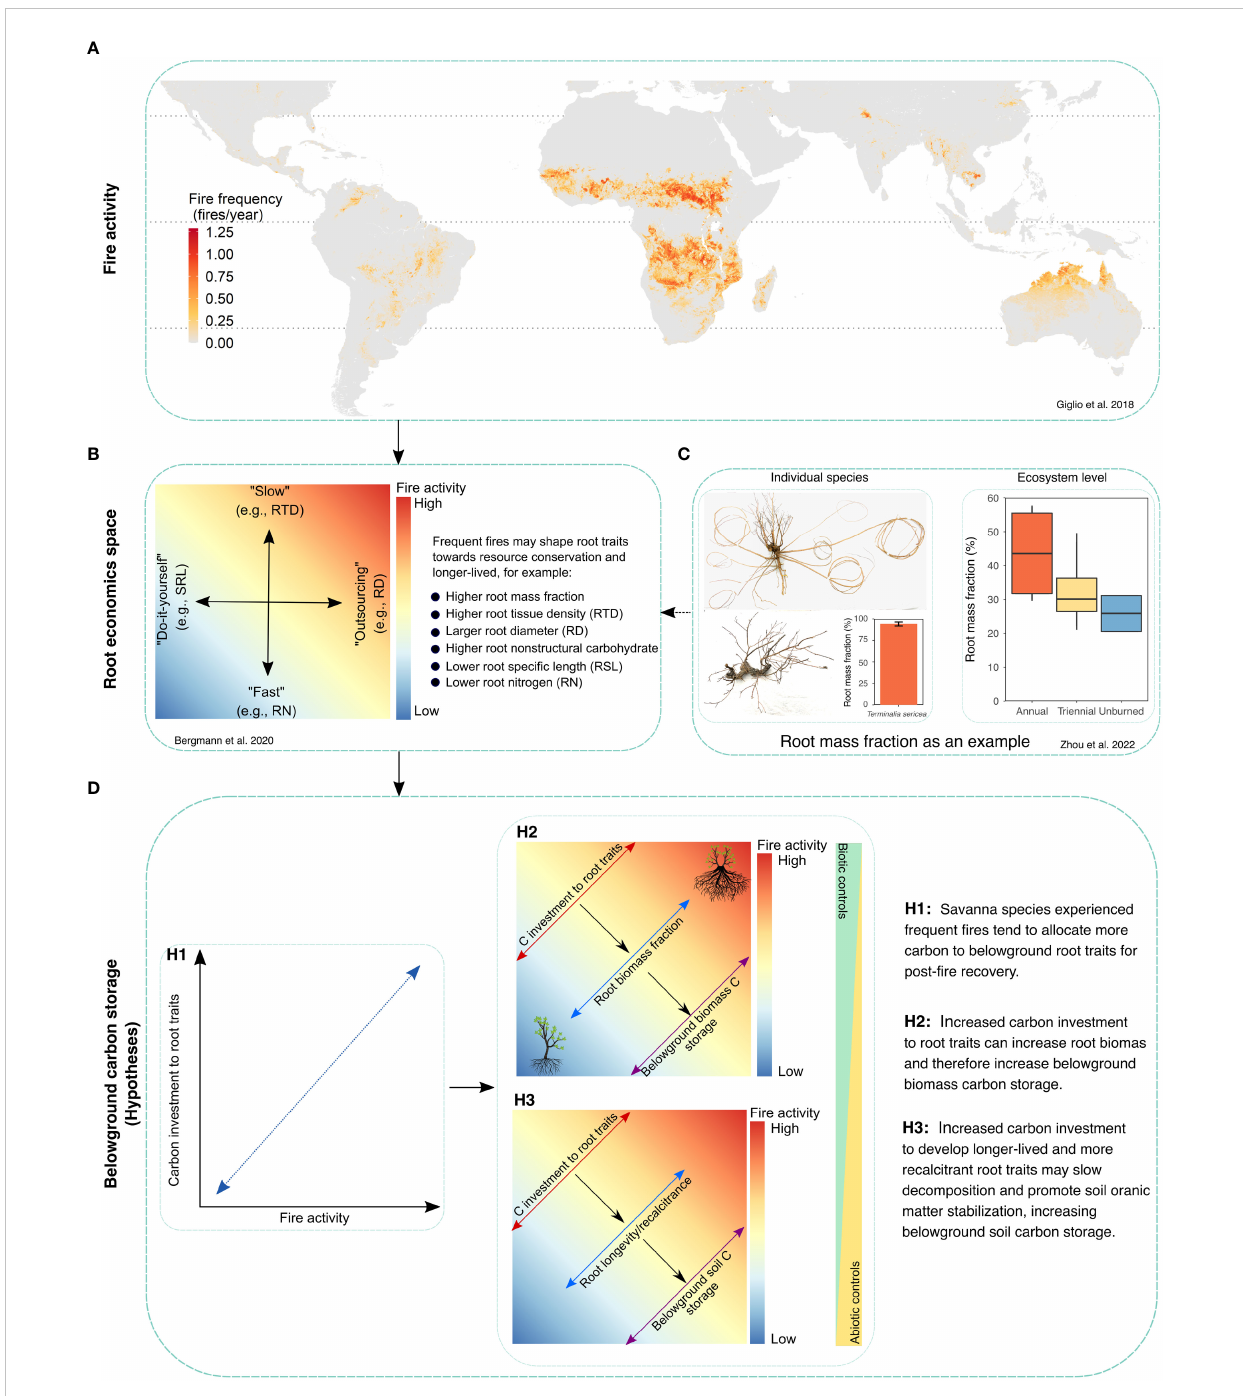
FIGURE 1 Linking root functional trait to understand belowground carbon dynamics in fi re-prone savannas. Panel (A) shows fi re frequency ( fi res/year) across tropical and subtropical savannas. Dataset were from the Moderate Resolution Imaging Spectroradiometer (MODIS) burned area product (Giglio et al., 2018). Panel (B) shows potential response of root traits to frequent fi res in savannas based on root economics space (Bergmann et al., 2020). Frequent fi res may shape root traits toward resource conservation and longer-lived, for example, higher root tissue density, higher root mass fraction, higher nonstructural carbohydrate, and lower root nitrogen content. Panel (C) shows an example of root mass fraction response to frequent fi res at the individual species and ecosystem level (Zhou et al., 2022). Root mass fraction of Terminalia sericea resprouters that experienced annual fi res can reach up to 95%, and savannas experienced more frequent fi res have higher root mass fraction at the ecosystem level than less and unburned ones in Kruger National Park, South Africa. Panel (D) shows a conceptual framework linking root traits to understanding belowground carbon storage in fi re-prone savannas. Savanna species experiencing more frequent fi res are expected to allocate more carbon for root traits (H1), which is hypothesized to lead to a higher belowground biomass carbon storage (H2) as well as soil carbon storage